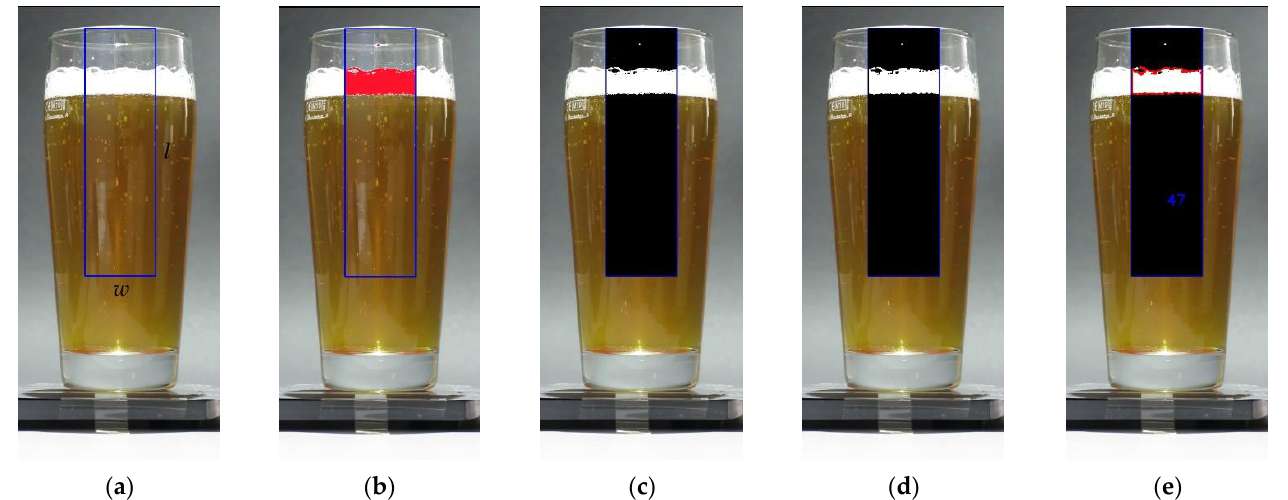
Figure 2. Estimating foam height from an image. ( a ) Region of interest (ROI) of known width ( w ) and height ( l ) defined for the image. The ROI is marked in blue; ( b ) thresholding of ROI performed in HSV color space. The pixels satisfying the threshold are marked in red; ( c ) binary image of ROI thresholded in HSV color space (a magnified image is provided in Figure 3a); ( d ) morphological operations of erosion followed by dilation performed on binary image to remove artifacts (a magnified image is provided in Figure 3b); ( e ) largest contour found marked in red. The estimated height of foam in pixels is determined using Equation (1).